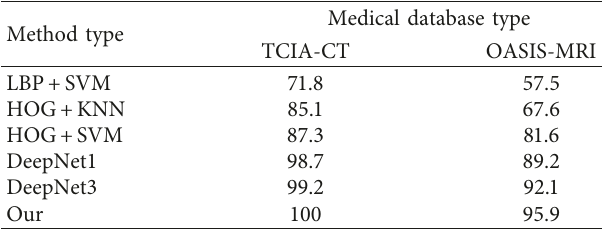
Figure 6: Examples from the OASIS-MRI database. Table 5: Comparison of classification accuracy of different clas- sification algorithms on two medical image databases (unit: